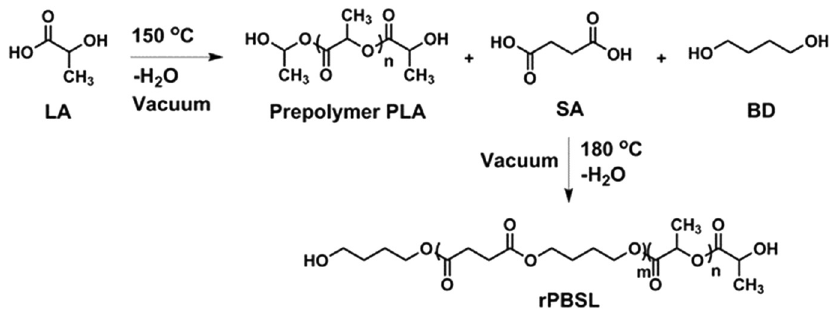
Figure 3: Preparation of rPBSL ( 28 ) . Copyright 2016. Reproduced with permission from